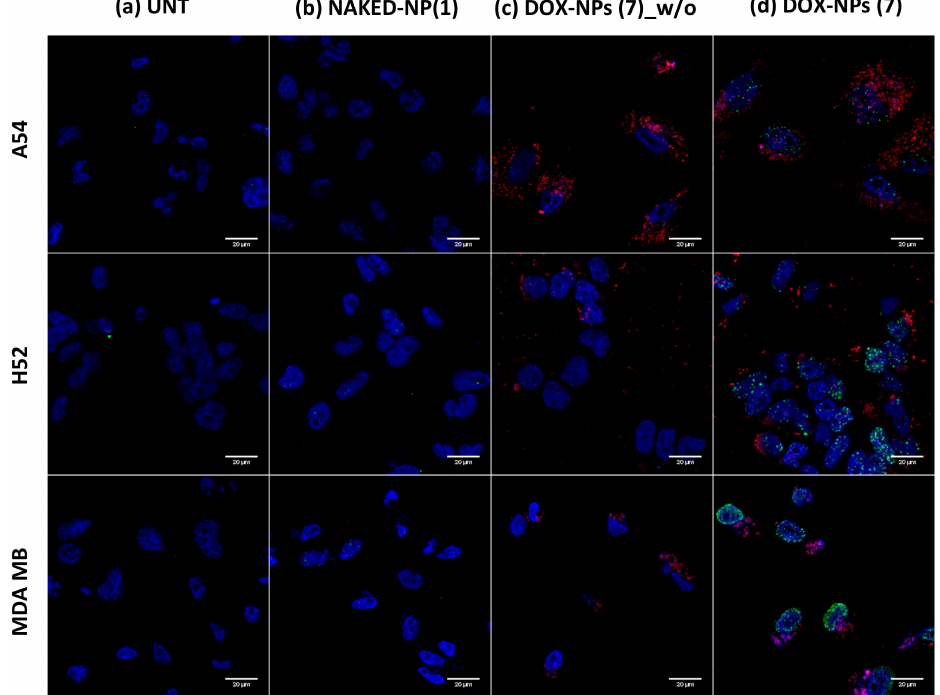
Figure 4. Evaluation of the DNA damage caused by the treatment with DOX-NPs ( 7 ) by immunostaining of γ -H2Ax in A549, H520, and MDA MB 231 cancer cell lines analyzed by confocal microcopy. The untreated cells (UNT) ( a ) and cells treated with NAKED-NPs (1) ( b ) were used as negative controls. Cells treated with DOX-NPs ( 7 ) were analyzed without ( c ) and with ( d ) a primary anti- γ -H2Ax antibody. Images with an increase of 63x show a composition of the four channels used: blue, DAPI for the nucleus staining; red, DOX-NPs ( 7 ); and green, for H2Ax staining with